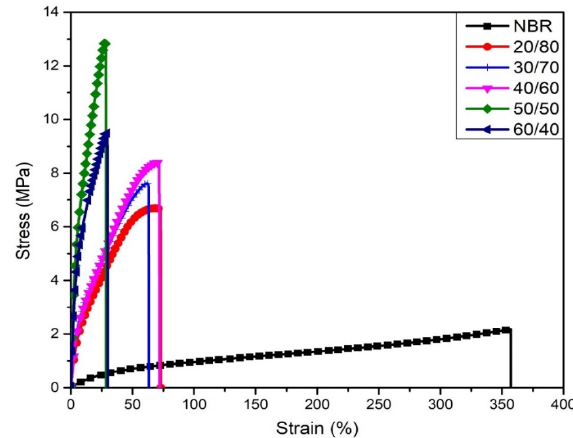
Figure 2. Stress–strain curve for various WLF/NBR ratio.